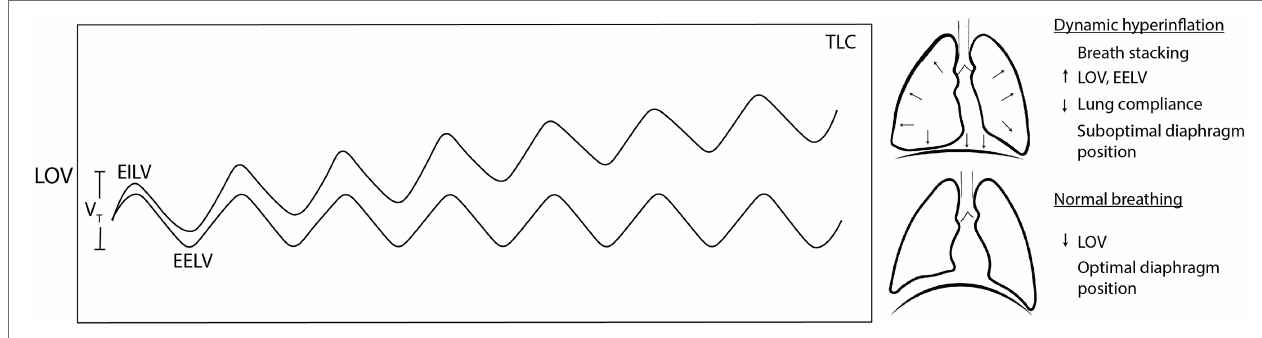
FIGURE 3 | Dynamic hyperinflation occurs when accumulated breath stacking progressively increases lung operating volume. When lung operating volume approaches total lung capacity, lung stiffness, and suboptimal diaphragm position increase the work of breathing (WOB) and dyspnoea. TLC, total lung capacity; LOV, lung operating volume; EILV, end-inspiratory lung volume; EELV, end-expiratory lung volume; and V T , tidal